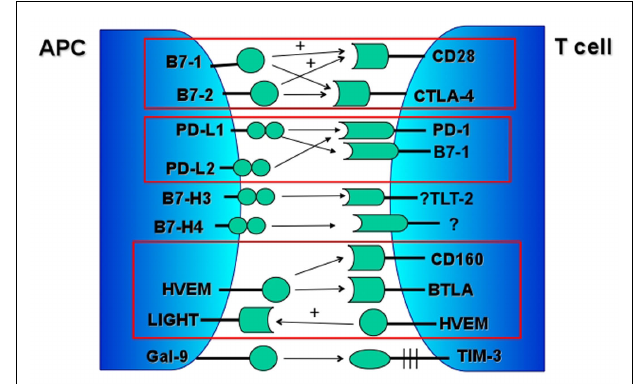
FIGURE 1 | Major negative costimulatory pathways. Associated positive signaling pathways marked with “ +